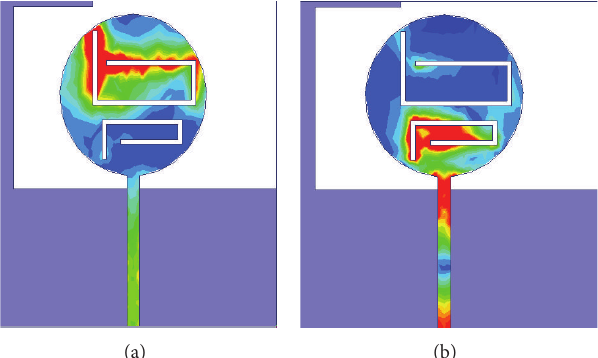
Figure 7: The current distributions on radiation patches. (a) Current distributions for band-notch at 3.0 GHz. (b) Current distributions for band-notch at 4.8